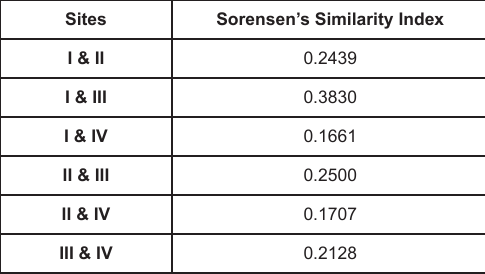
after the last sampling.